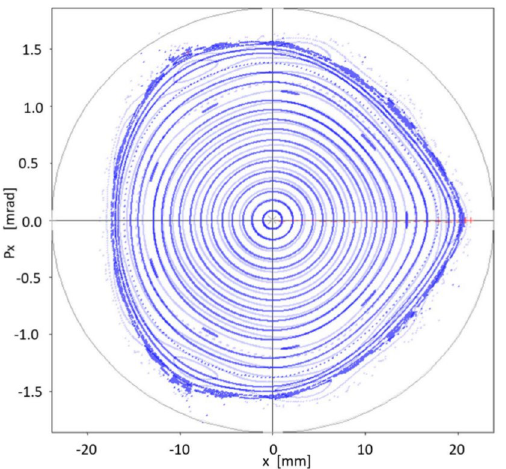
Figure 18. Structure of the phase space ( x , p x ) according to OPA’s particle tracking simulation (dark blue) done with the { S 3 } set of sextupoles obtained for a 12 mm amplitude optimization. In faint blue (background) the optimization at 10 mm of Fig. 11 is shown. In the new calculation (dark blue) there is a slight increase in the phase space area. Both structures (blue dark and faint) in phase space are for on-momentum particles ( δ = 0